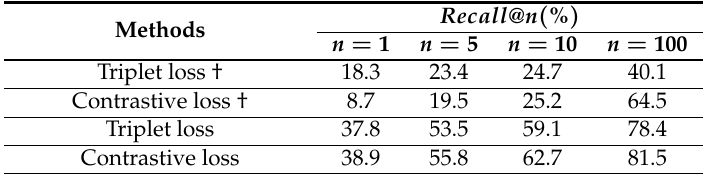
Table 1. Results of the conventional learning method (with cross-channel pooling) trained on the Google Earth South Korea dataset (Recall@n).